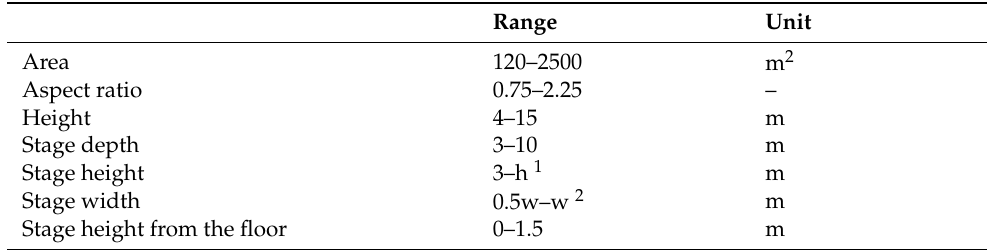
Figure 6. Source and receiver points. Table 2. Setting conditions of parametric model. Figure 5. The basic spatial form.